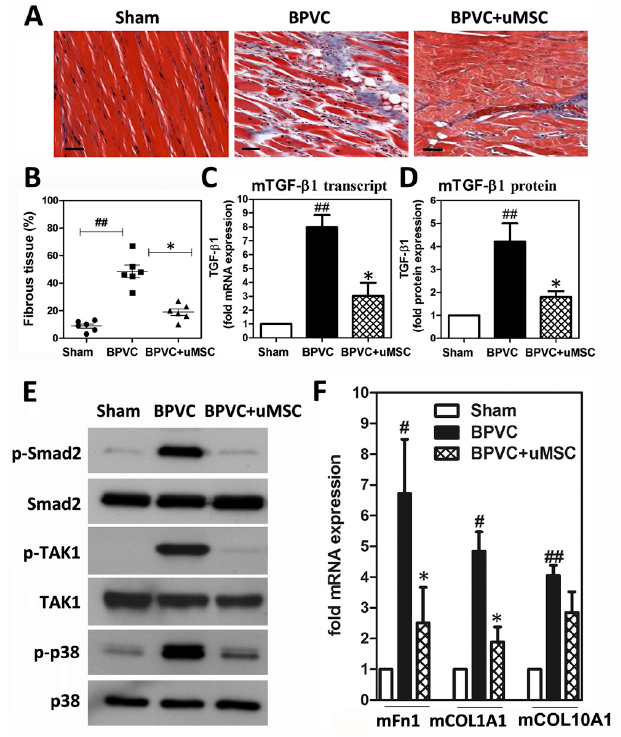
Figure 5. The presence of uMSCs abrogated BPVC-induced fibrosis. Quadriceps muscles were isolated from three groups of C57BL/6 mice after two weeks of BPVC injection or uMSC transplantation. ( A ) Representative immunohistochemistry figures of quadriceps muscles with the nuclei stained black, the muscle cells stained red, and fibrous tissue stained blue by Masson’s